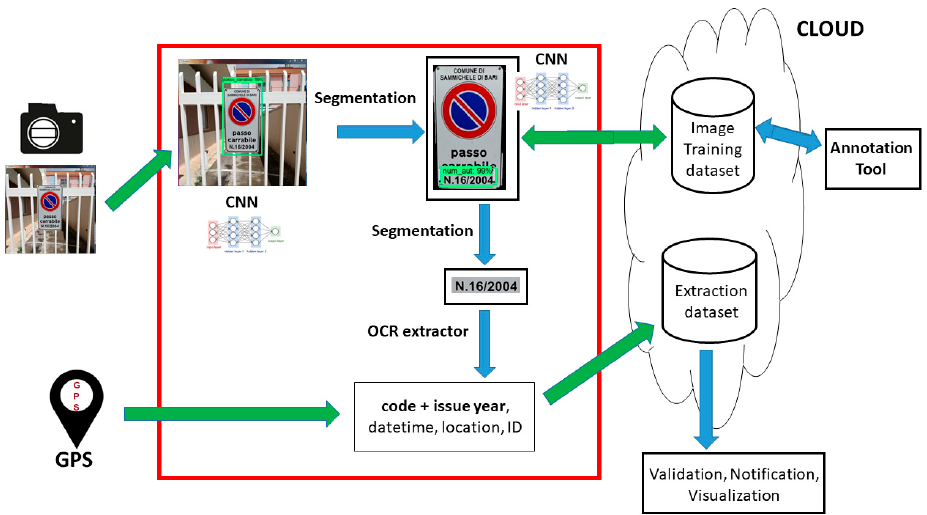
Figure 2. The proposed architecture for an integrated system. CNN = convolutional neural networks; OCR = optical character recognition; GPS = Global Positioning System.